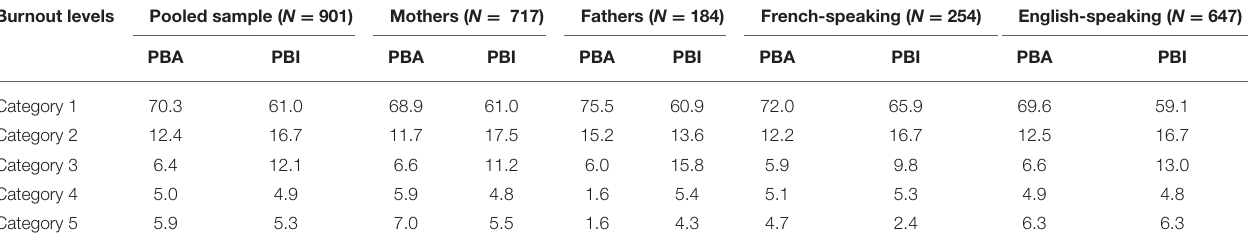
TABLE 4 | Percentage of parents belonging to each category (higher categories = higher burnout scores) according to the PBA and the PBI. Burnout levels Pooled sample ( N = 901) Mothers ( N = 717) Fathers ( N = 184) French-speaking ( N = 254) English-speaking ( N = 647)